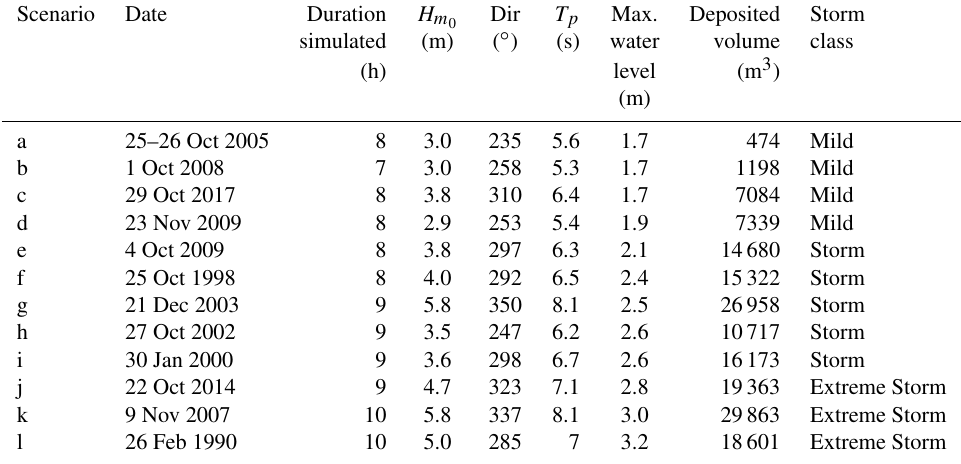
Table 2. Characteristics of the simulated scenarios. Deposited volume refers to the amount of sand deposited onto the sand flat according to the simulation